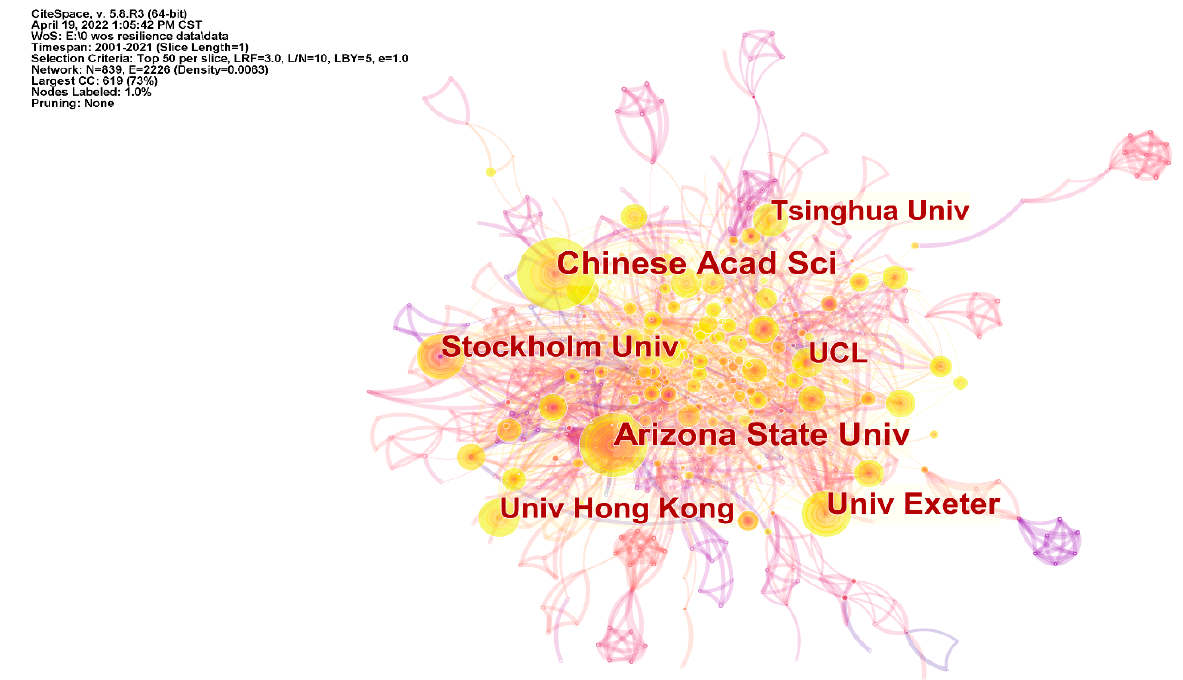
Figure 4. Collaborative co-existence map of RC research institutions.